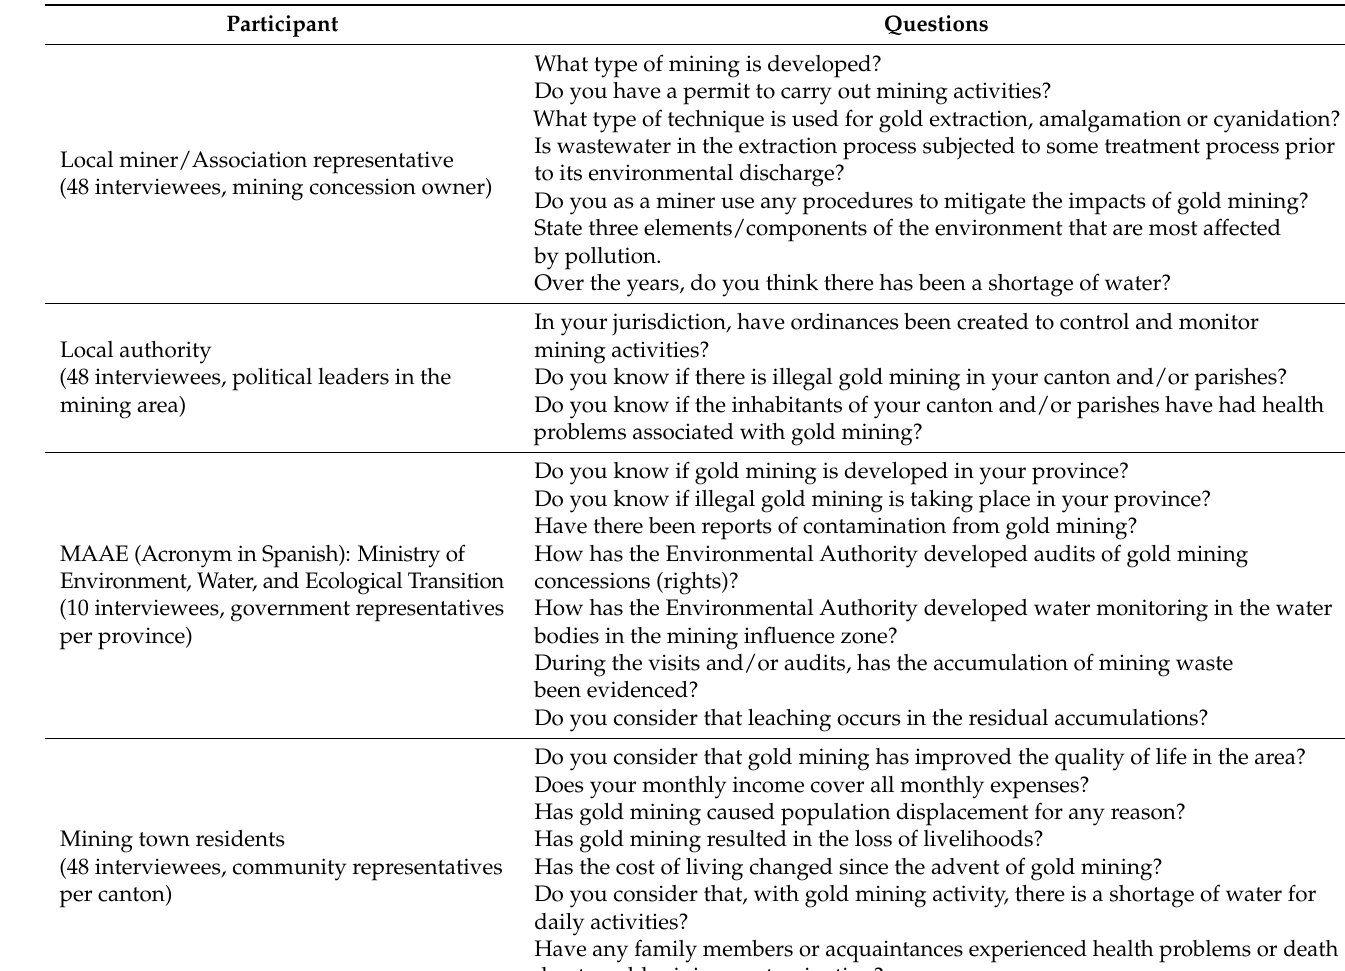
Table 4. Participants and key questions to understand the current situation of gold mining in the Amazon